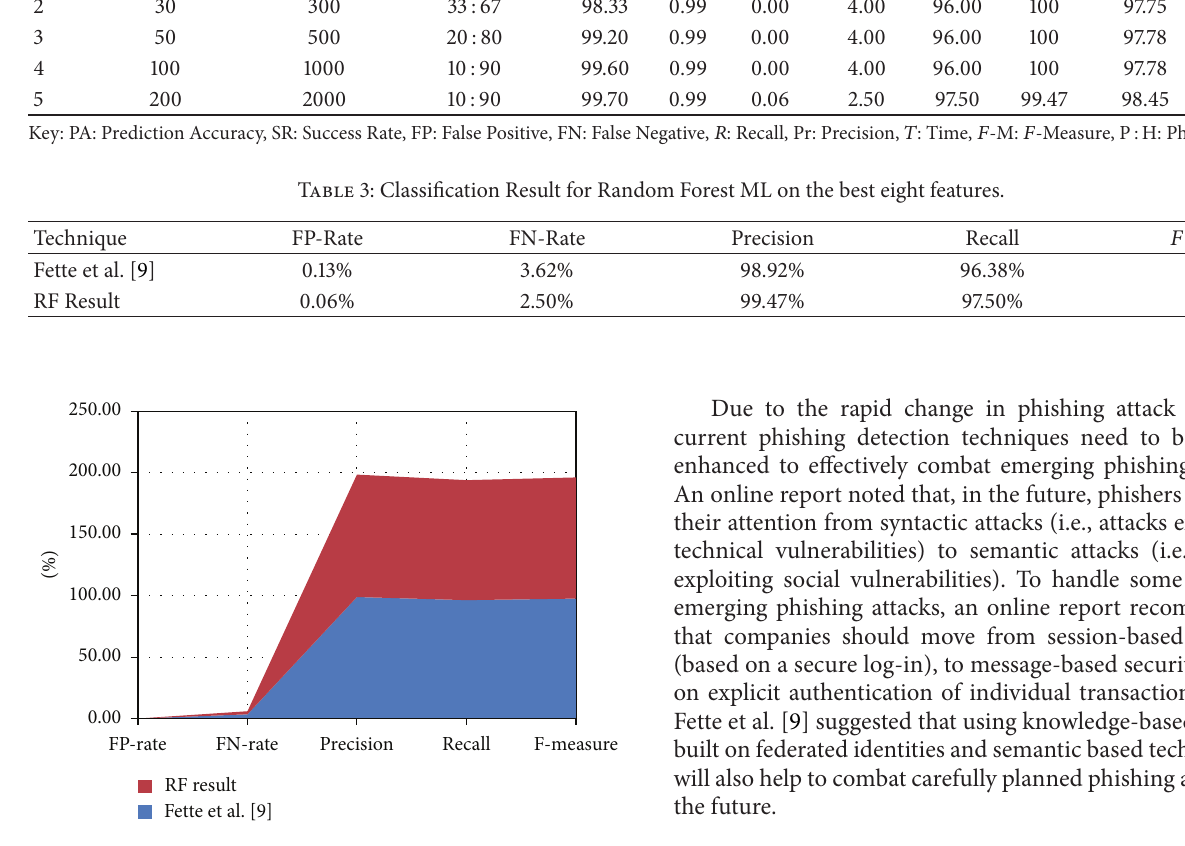
Figure 1: ROC curve showing the comparison between our work and Fette et al.’s